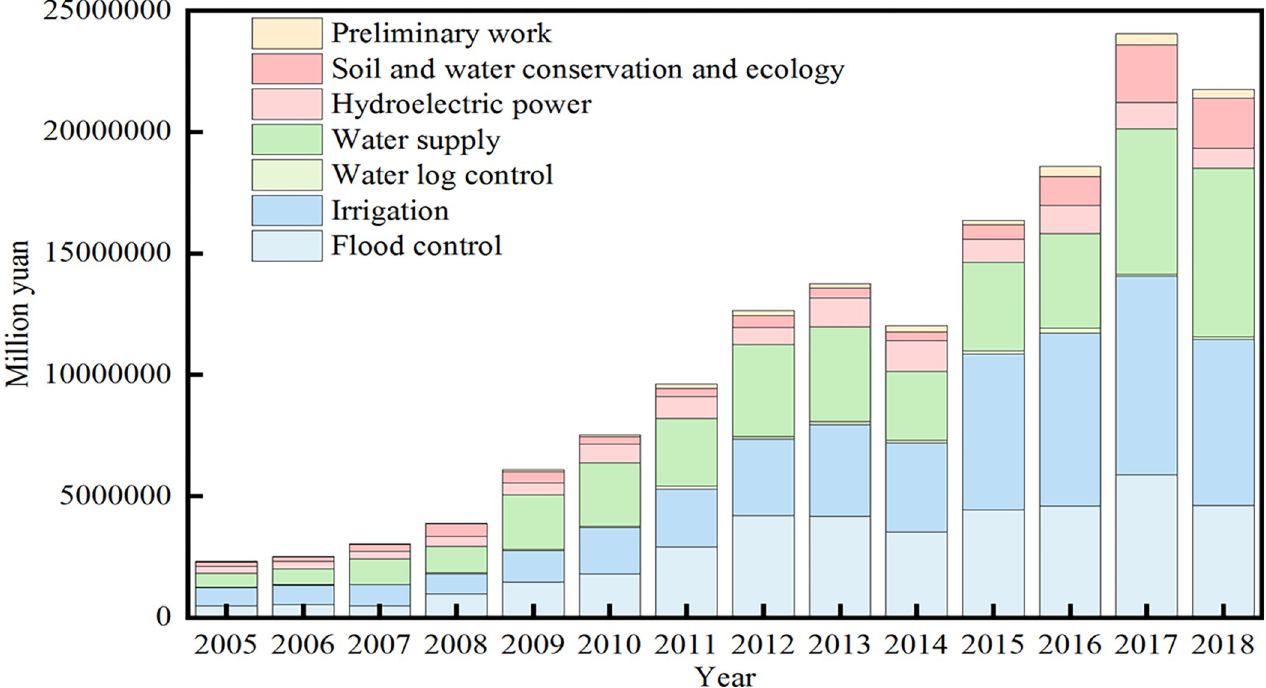
Fig 3. Distribution map of agricultural water salvation investment by purpose in the Eastern region.